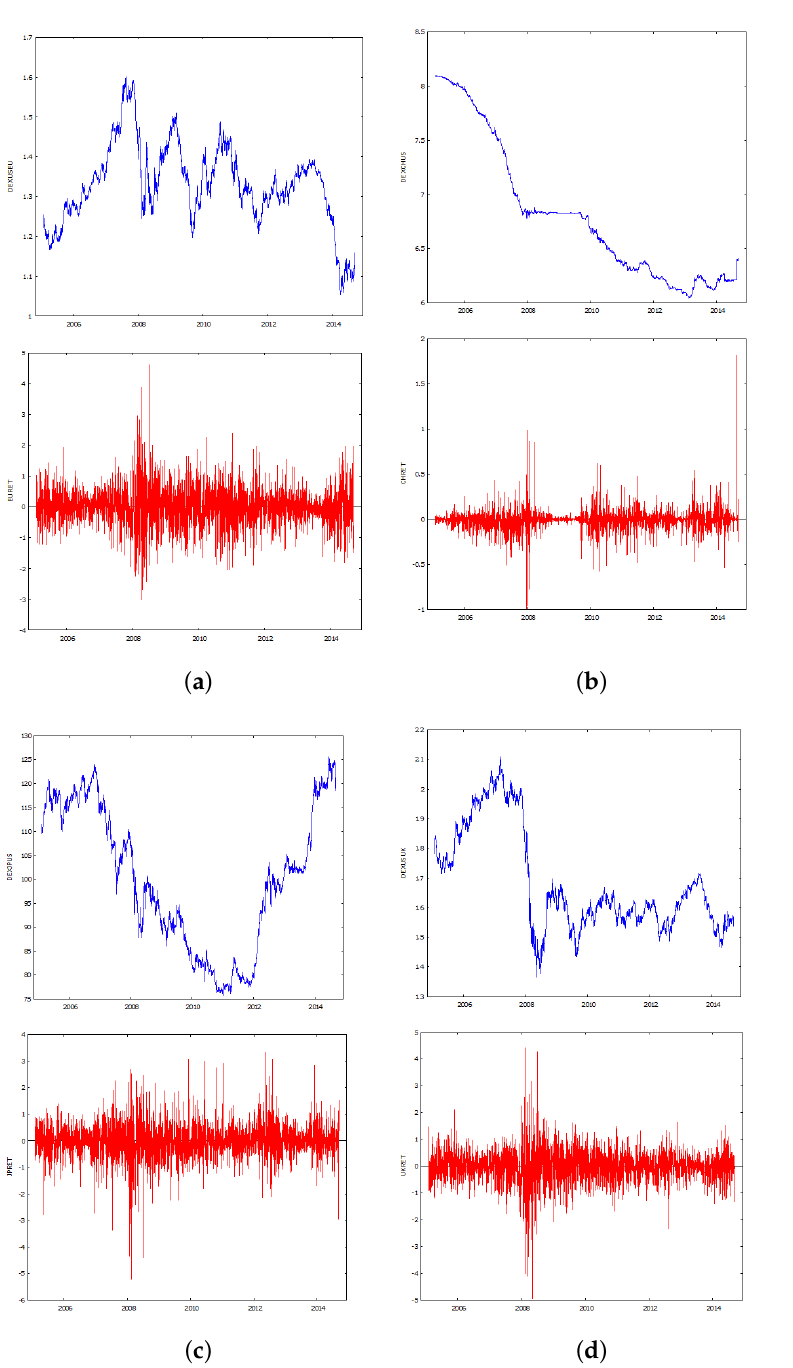
Figure 1. Time series plots of the base series and their logarithmic differences. ( a ) US -EURO; ( b ) US-CHINA; ( c ) US-JAPAN; ( d )